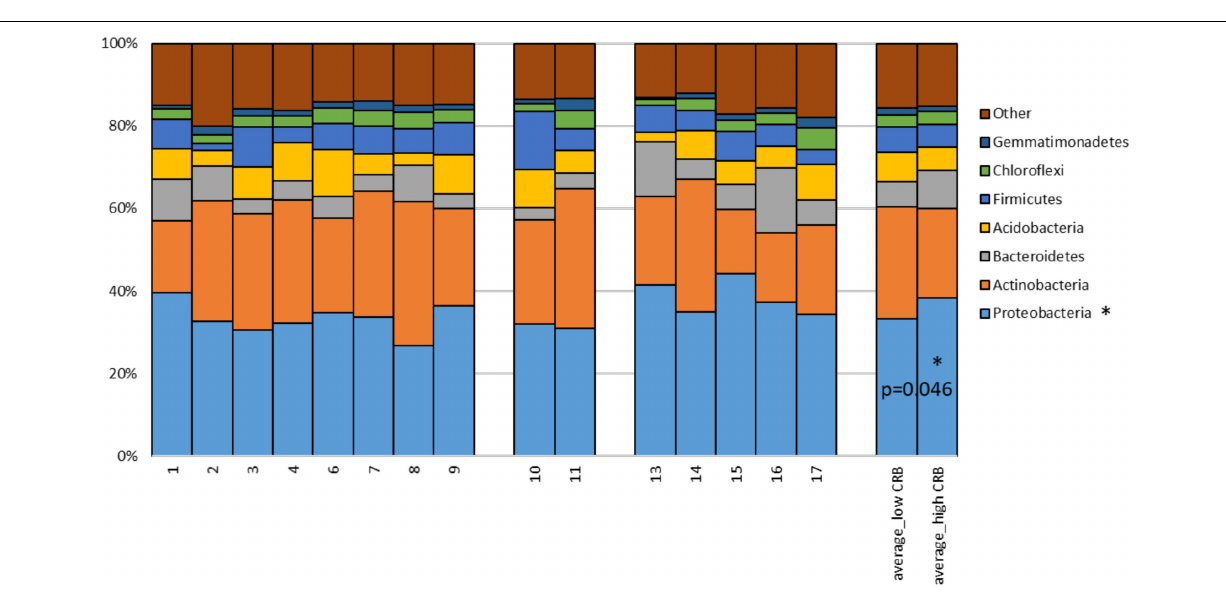
FIGURE 5 | Proportions of 16S rDNA sequences matching to dominant phyla detected in soils. The percentage of reads matching to dominant phyla is provided for each farm soil. Mean proportions of phyla for farms divided by low and high CRB status are provided on the right, P -value derived from Student’s T -test (unpaired, two-tailed). OTUs matching phyla with sequence abundance < 1.0% ( TM7 , Planctomycetes , Nitrospirae , Cyanobacteria , WS6 , Fibrobacteres , Armatimonadetes, Chlorobi , OD1 , TM6 , BRC1 , Elusimicrobia , Verrucomicrobia , AD3 , Tenericutes , Spirochaetes , GN02 , OP11 , MVP-21 , FBP , FCPU426, BHI80-139,